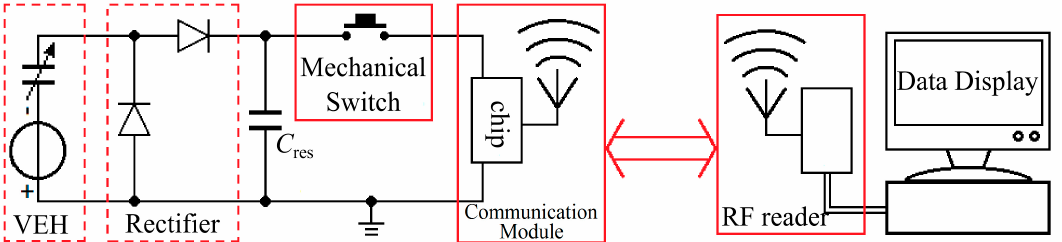
Figure 1. Schematic of the proposed VEH-assisted RFID system read by a distant RF reader (up to 15 m apart).